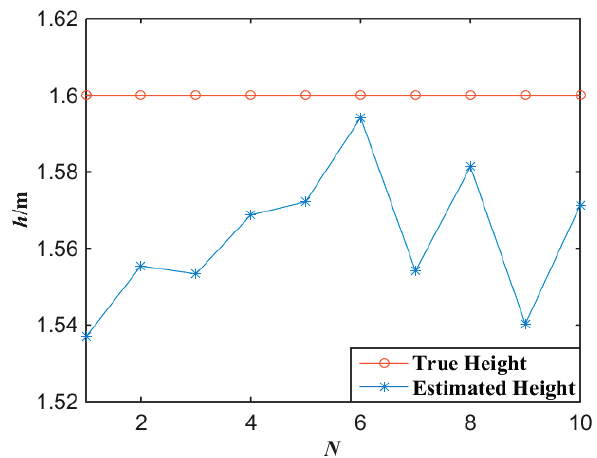
Figure 6. Experimental data of altitude with the miner’s lamp video collaborative localization.